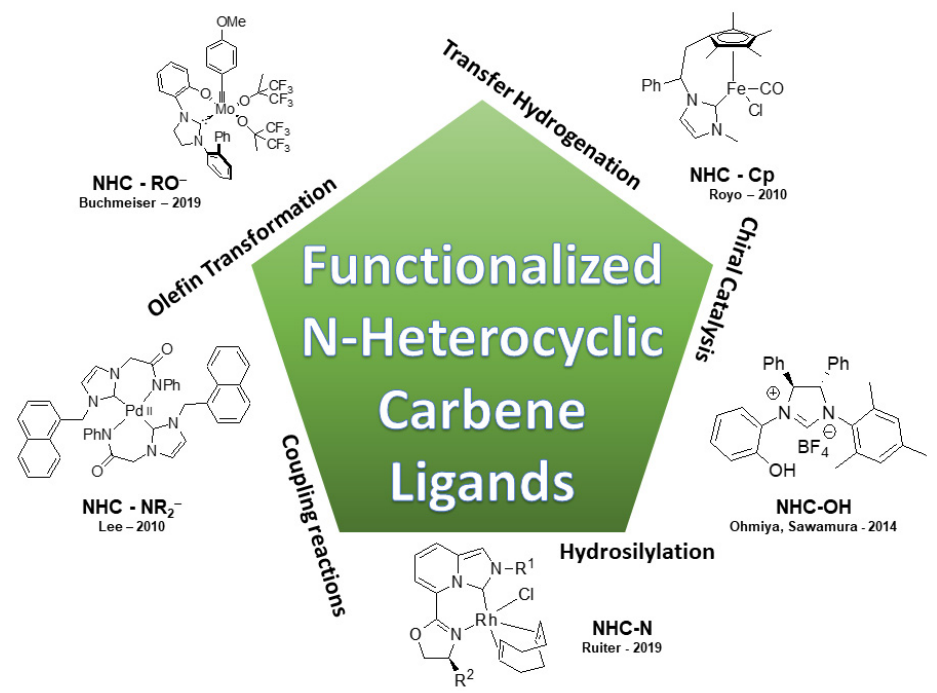
Figure 1. Selected examples of tethering bidentate NHCs ligands bearing neutral or anionic moieties.